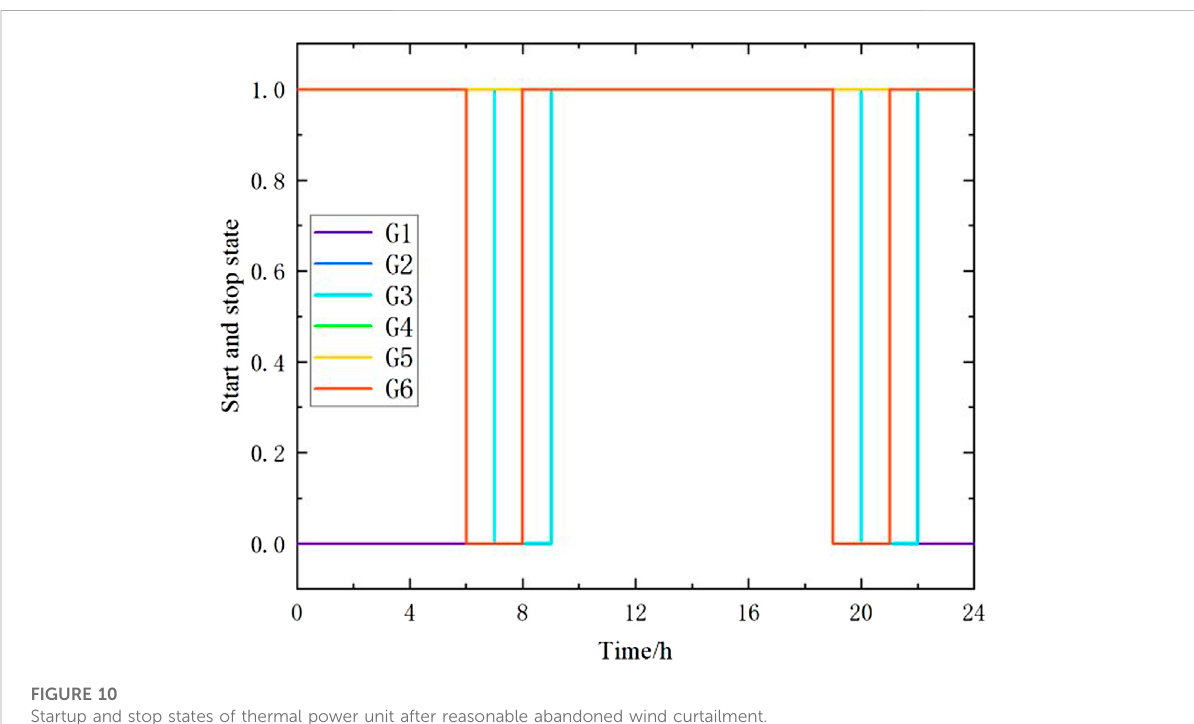
FIGURE 10 Startup and stop states of thermal power unit after reasonable abandoned wind curtailment.